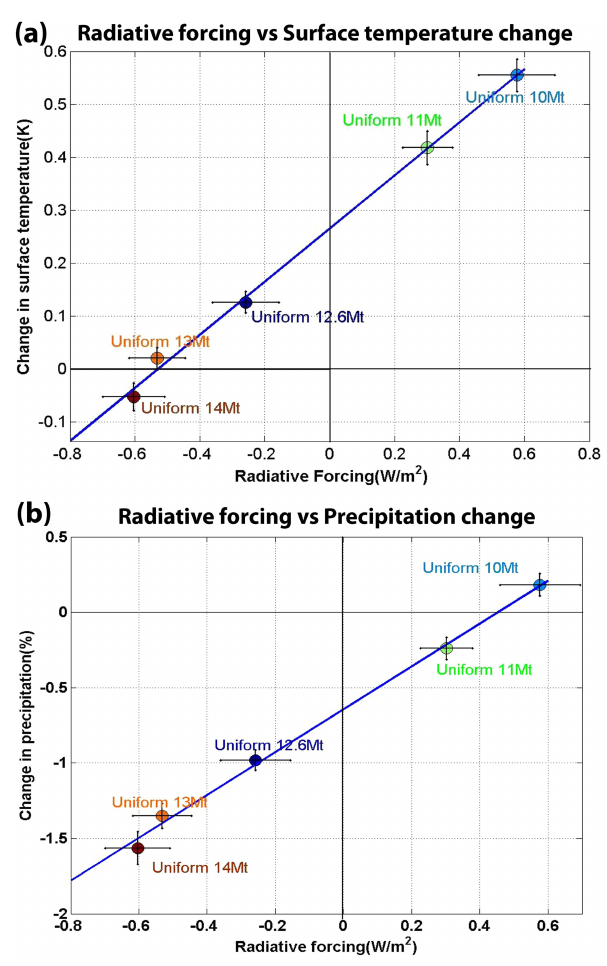
Figure 3. (a) Radiative forcing (RF) vs surface temperature change, (b) radiative forcing vs % precipitation change for uniform distribu- tion scenarios with 10Mt, 11Mt, 12.6Mt, 13Mt and 14Mt. More aerosol mass leads to negative residual radiative forcing and hence cooler and drier climate, and smaller aerosol mass leads to positive residual radiative forcing and hence warmer and wetter climate. In (a) and (b) the horizontal and vertical bars represent the standard error of the respective variables. Results shown are averages of the last 20 years of 50-year SOM simulations for temperature and pre- cipitation while the last 20 years of 40-year fixed-SST simulations are used for radiative forcing calculations.